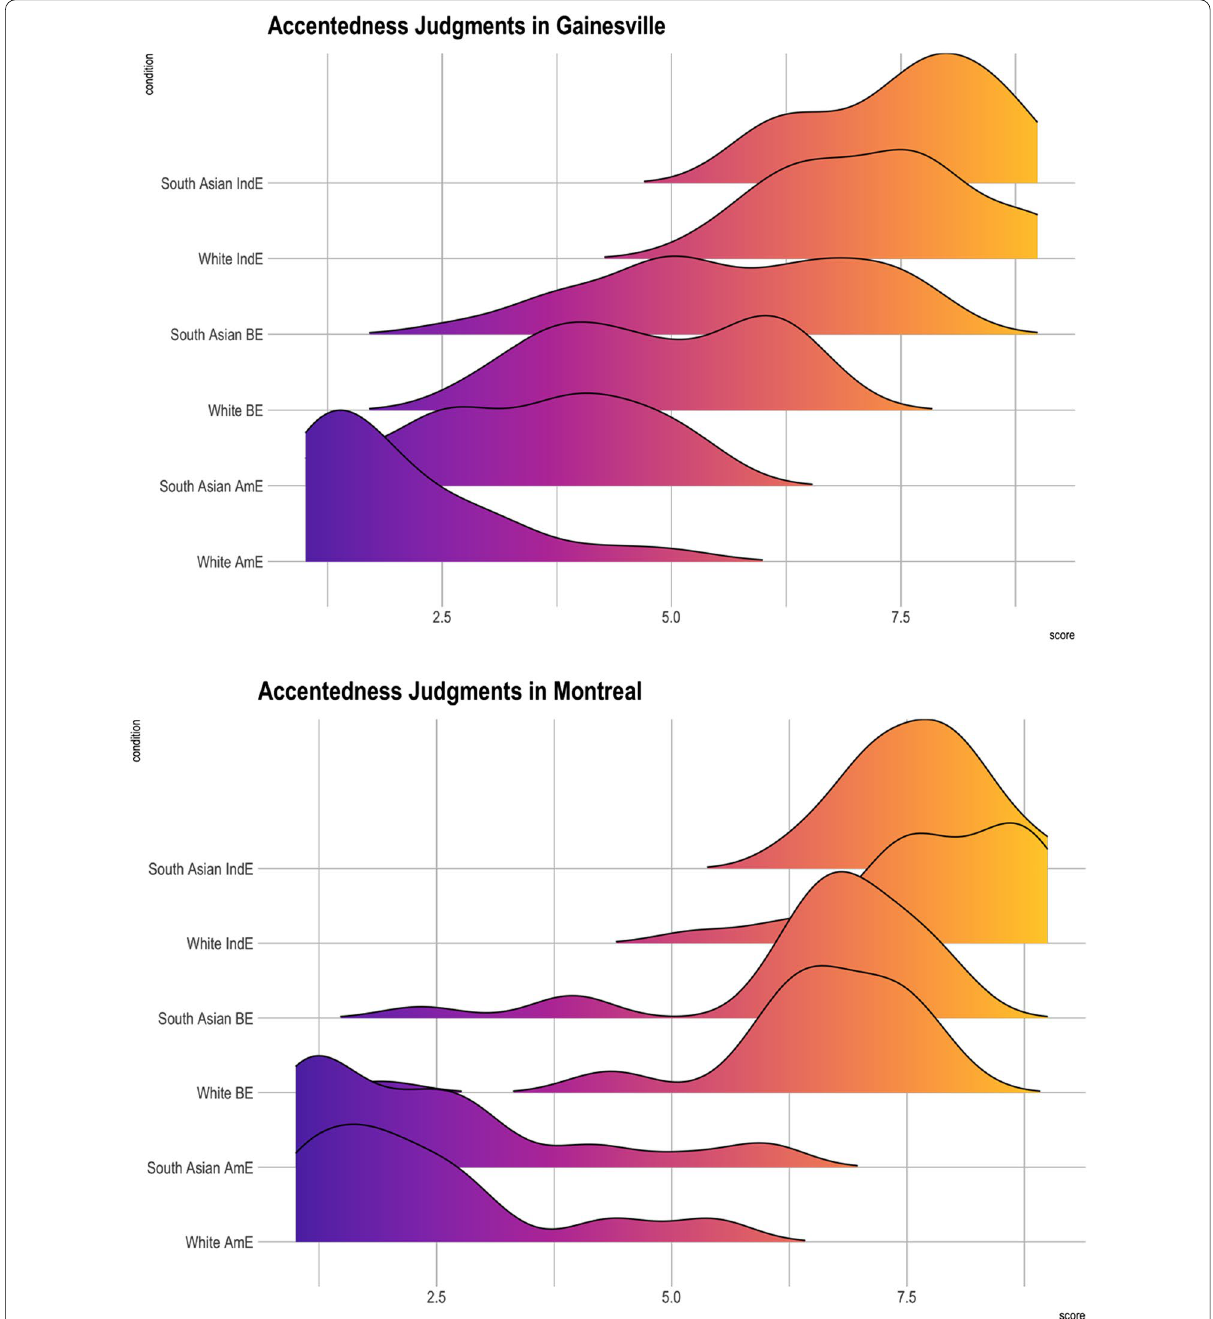
Fig. 5 Accentedness judgments in Montreal and in Gainesville for each face and variety